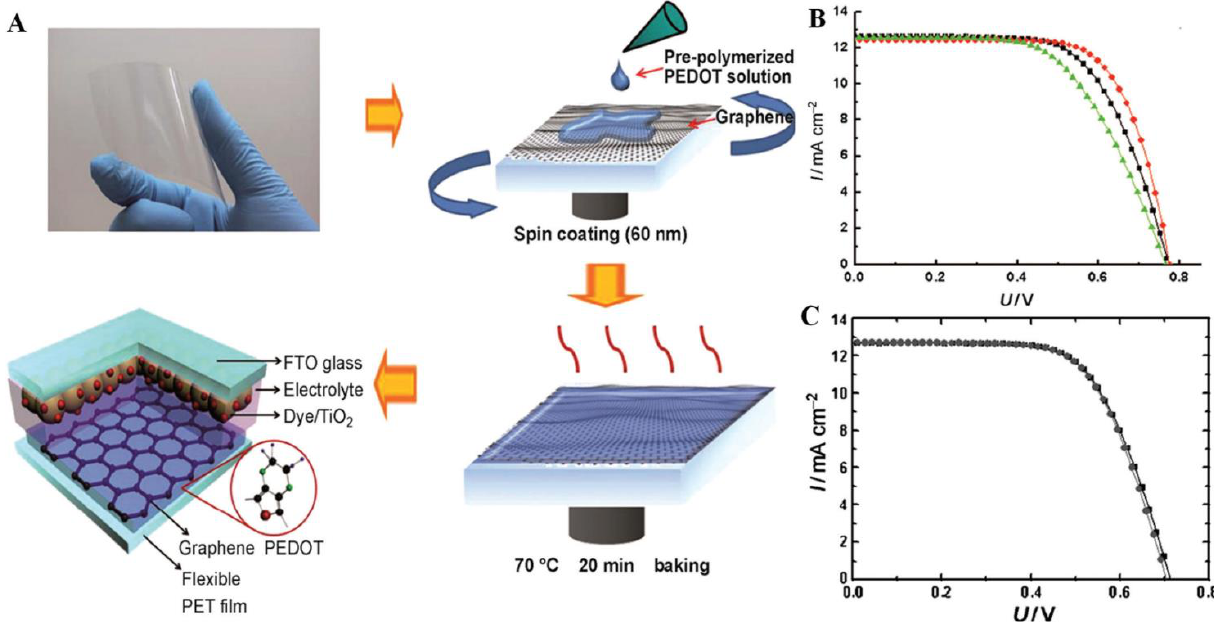
Figure 4. ( A ) G-coated PET and representation of the preparation process of a DSSC with a PEDOT/G/PET counter electrode. ( B ) J–V characteristics of the cells with PEDOT/G/PET (black), PEDOT/PET (green) and Pt/ITO/PET (red) as counter electrode. ( C ) J–V characteristics of bended (circles) and pristine (squares) DSSCs using a PEDOT/G/PET counter electrode. Reprinted with permission from Ref. [85]. Copyright 2012 WILEY-VCH Verlag GmbH & Co. KGaA,